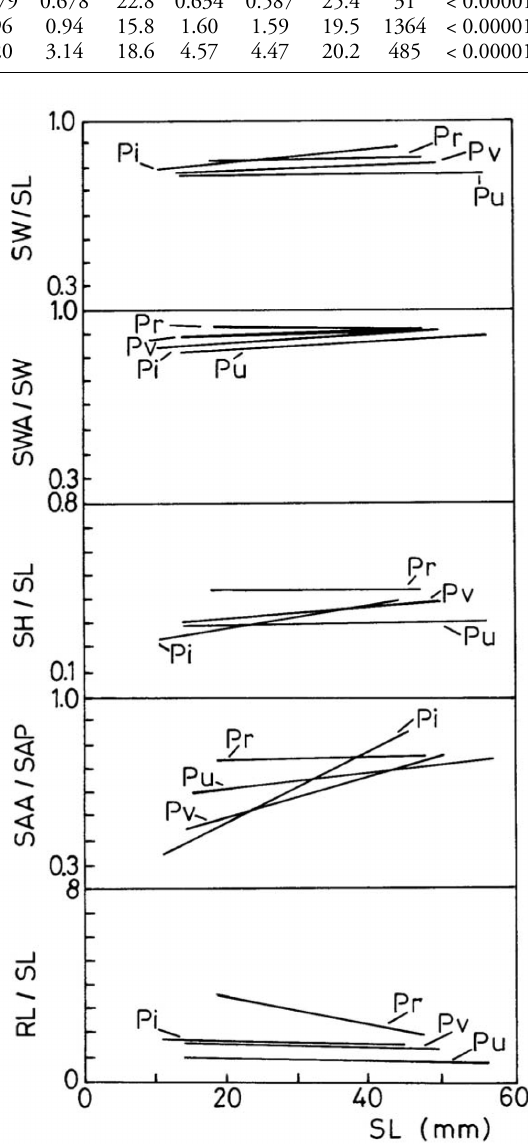
Fig. 3. Plots of ratios describing shell shape or radula relative size changes during growth against shell length. Only the regression lines are displayed (Pi = P. intermedia , Pr = P. rustica , Pu = P. ulys- siponensis , Pv = P. vulgata